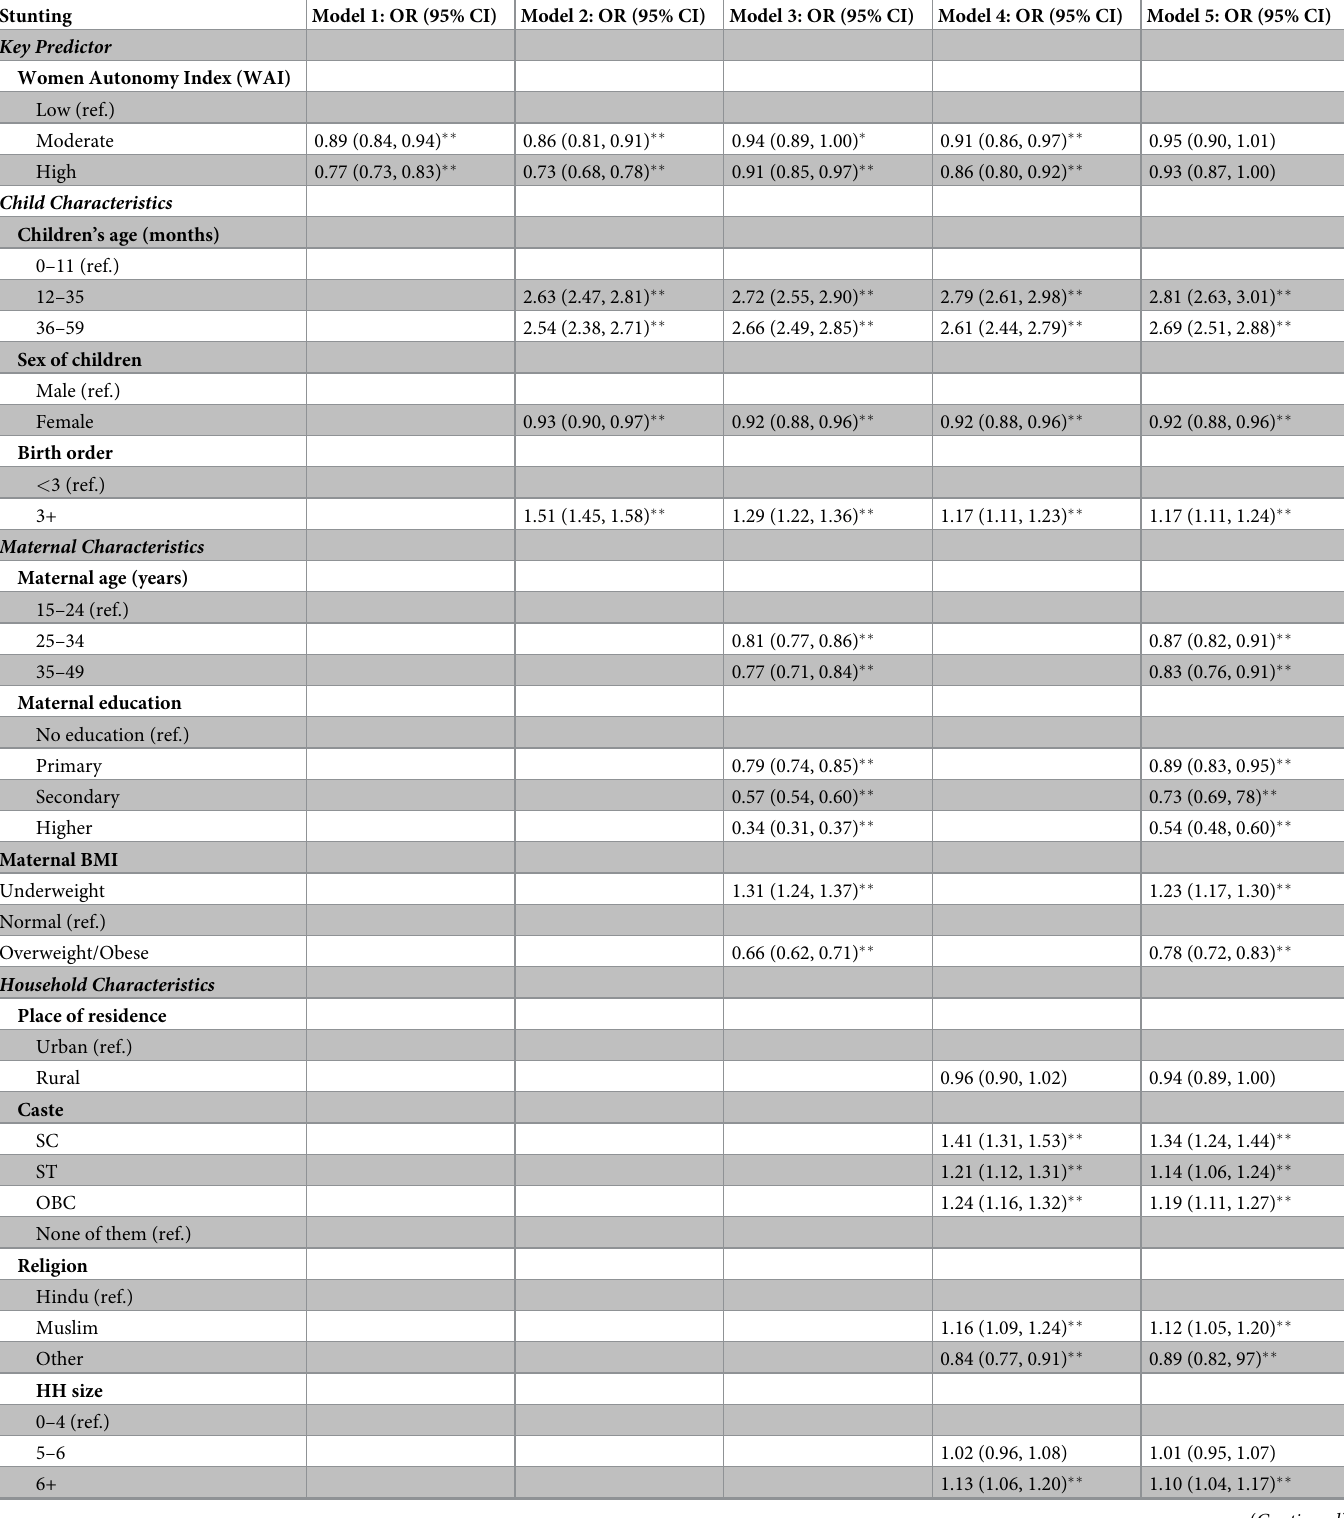
Table 3. Binary logistic regression models assessing the association between maternal autonomy and stunting among under-five children, NFHS-4 (2015–16).